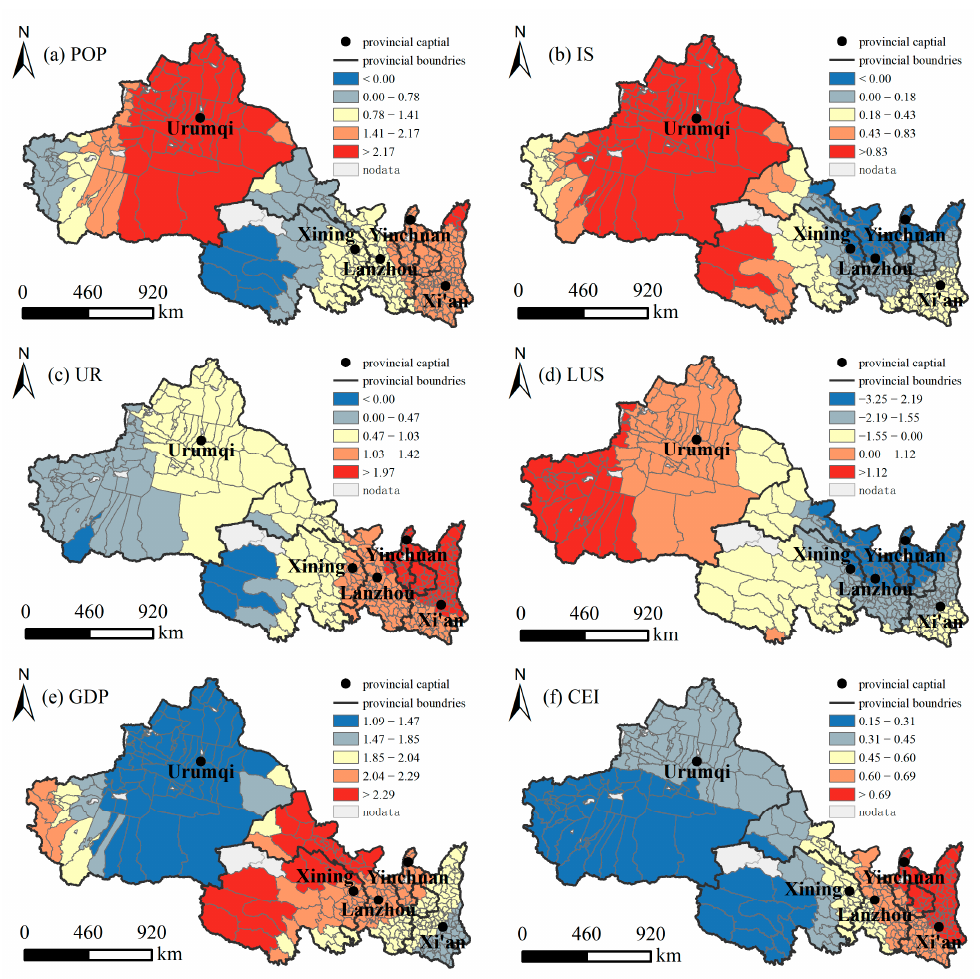
Figure 9. Spatial pattern of the mean of the regression coefficients of factors.